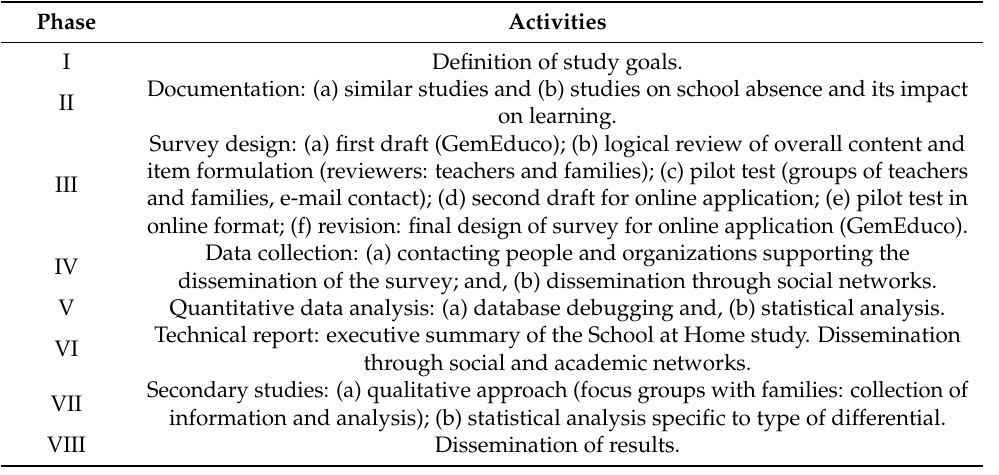
Table 4. Phases of study development: School at